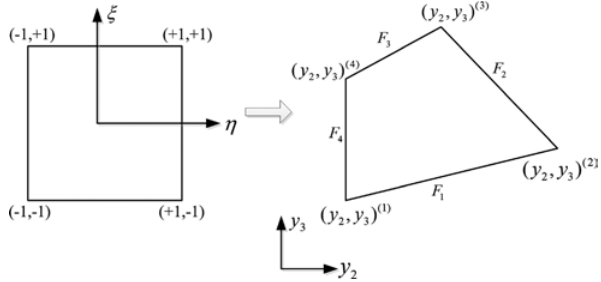
Figure 2: Mapping transformation in parametric